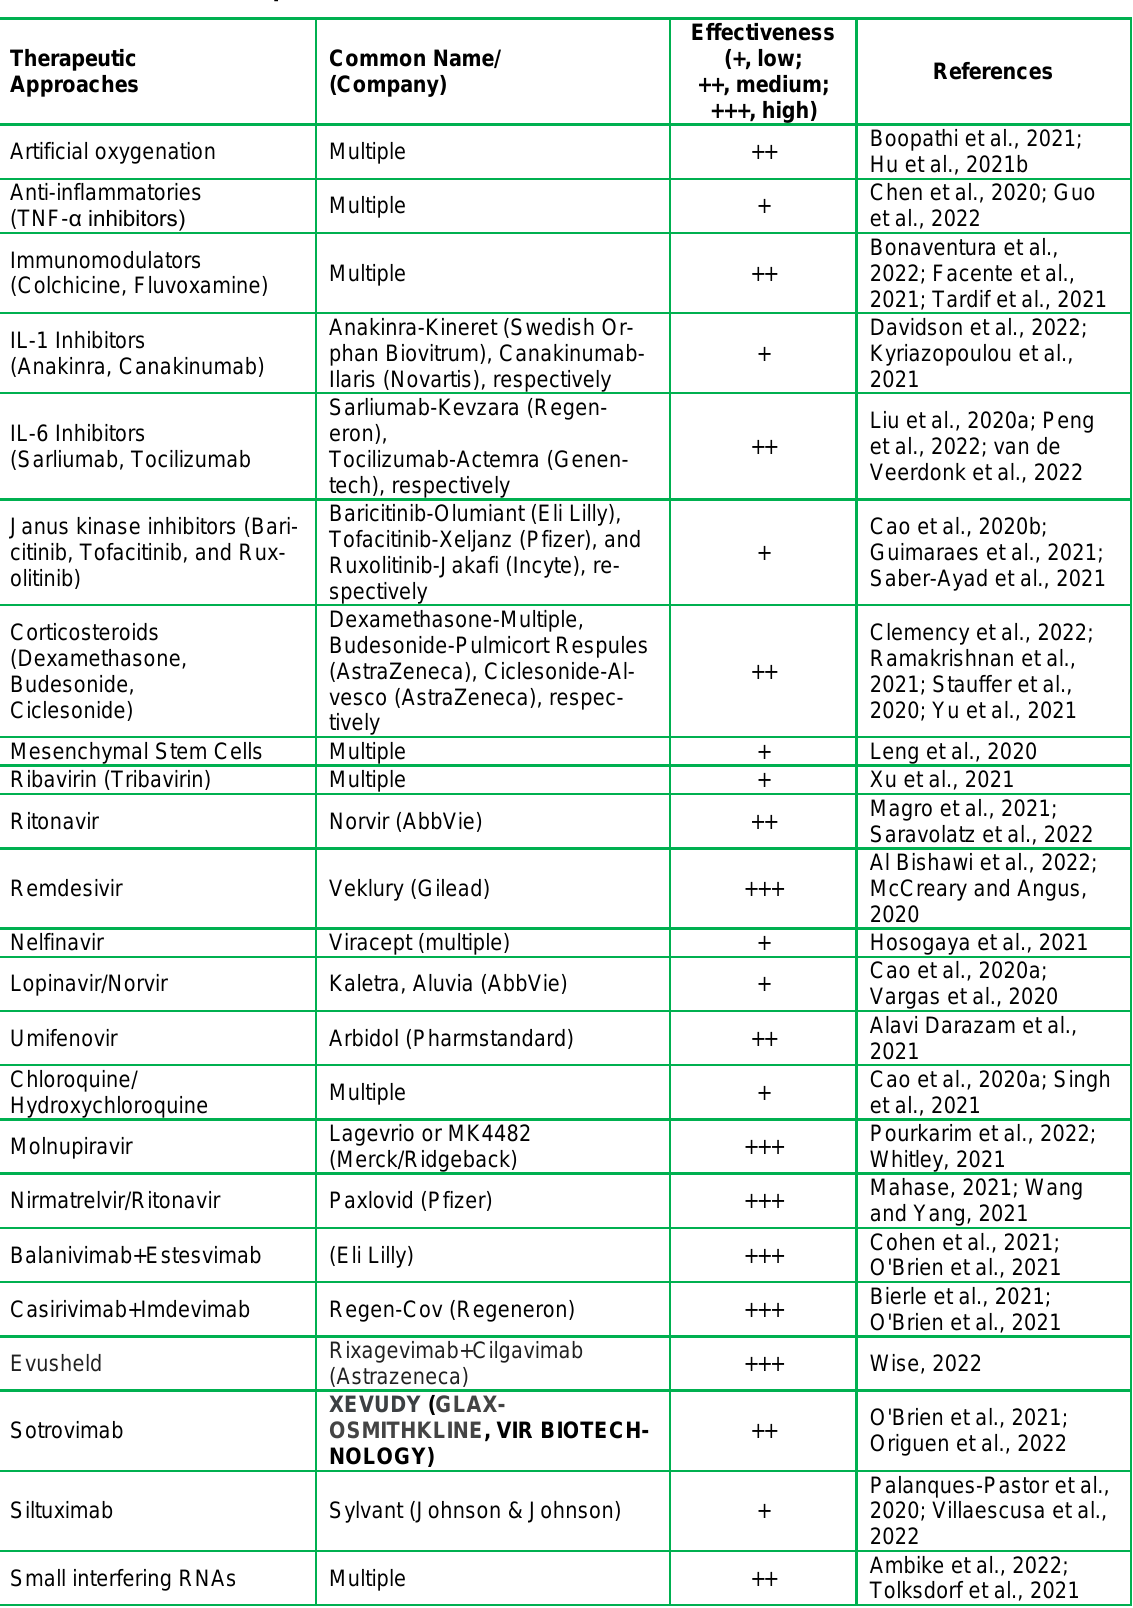
Table 3: Potential therapeutic interventions for the treatment of COVID-19 and its